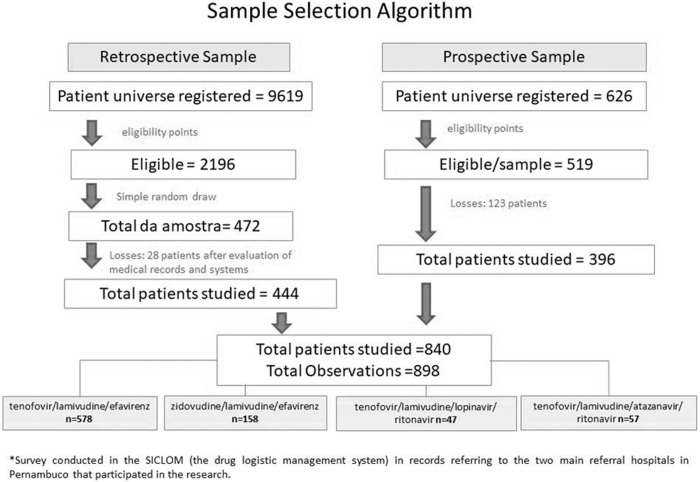
Sample selection.